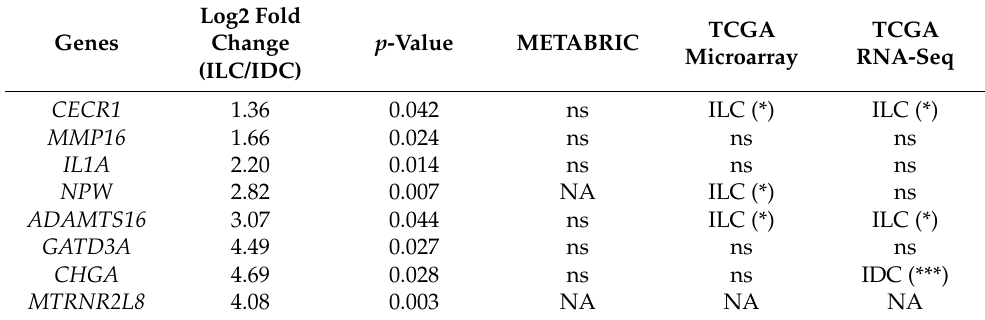
Table 2. Genes encoding secreted proteins are significantly upregulated in ILC CAFs. Expression of the 8 significant (Mann–Whitney U test, p < 0.05) secreted protein-encoding genes upregulated in ILC CAFs compared to IDC CAFs in CAF RNA-Seq dataset. Log 2 (fold changes) for CAF RNA-Seq dataset are log 2 (ILC/IDC) with corresponding p -values. Significance levels shown for individual gene expression levels in METABRIC and TCGA bulk tumor datasets. ILC or IDC indicates significant increase in expression in that subtype; Mann–Whitney U test, * p < 0.05, *** p < 0.0001, ns = not significant; NA = data not available. Log2 Fold TCGA TCGA p -Value METABRIC Genes Change Microarray RNA-Seq (ILC/IDC) CECR1 1.36 0.042 ns ILC (*) ILC (*) MMP16 1.66 0.024 ns ns ns IL1A 2.20 0.014 ns ns ns NPW 2.82 0.007 NA ILC (*) ns ADAMTS16 3.07 0.044 ns ILC (*) ILC (*) GATD3A 4.49 0.027 ns ns ns CHGA 4.69 0.028 ns ns IDC (***) MTRNR2L8 4.08 0.003